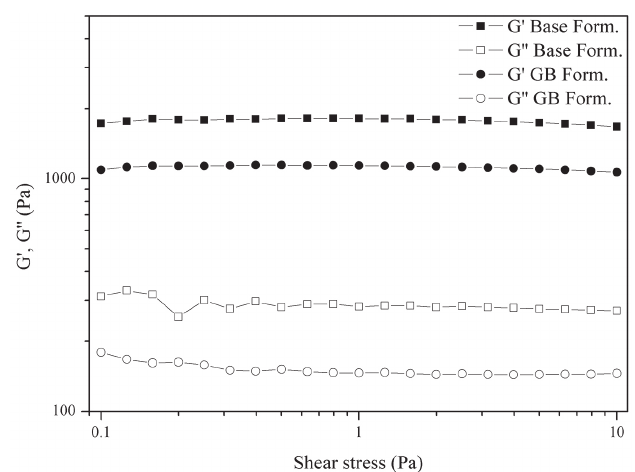
FIGURE 3 - Shear stress of the formulations containing or not the GB soft extract.